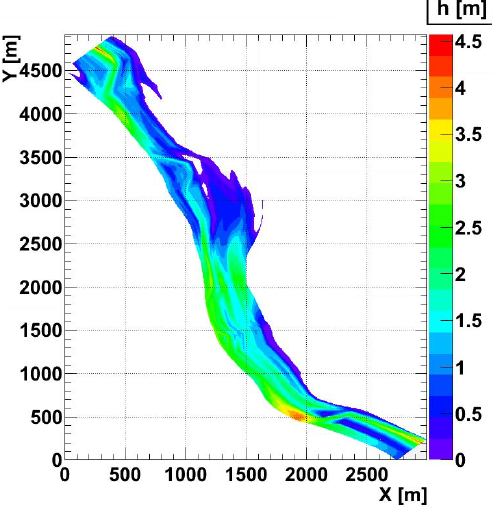
Fig. 3. The velocity magnitude for the considered reach of the Vis- tula River, computed for the averaged low-flow